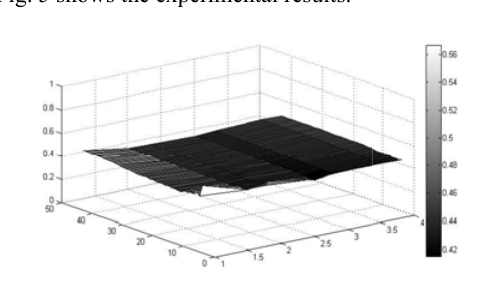
Figure 5. Verti Left Horizonta Right Horizont From Fig.